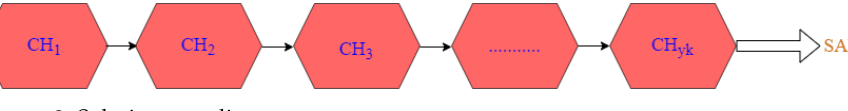
Figure 2. Solution